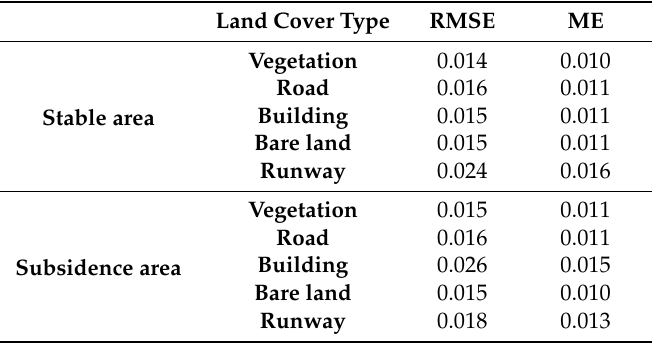
Table 4. The fitting error of the mean temporal decorrelation model of different land cover